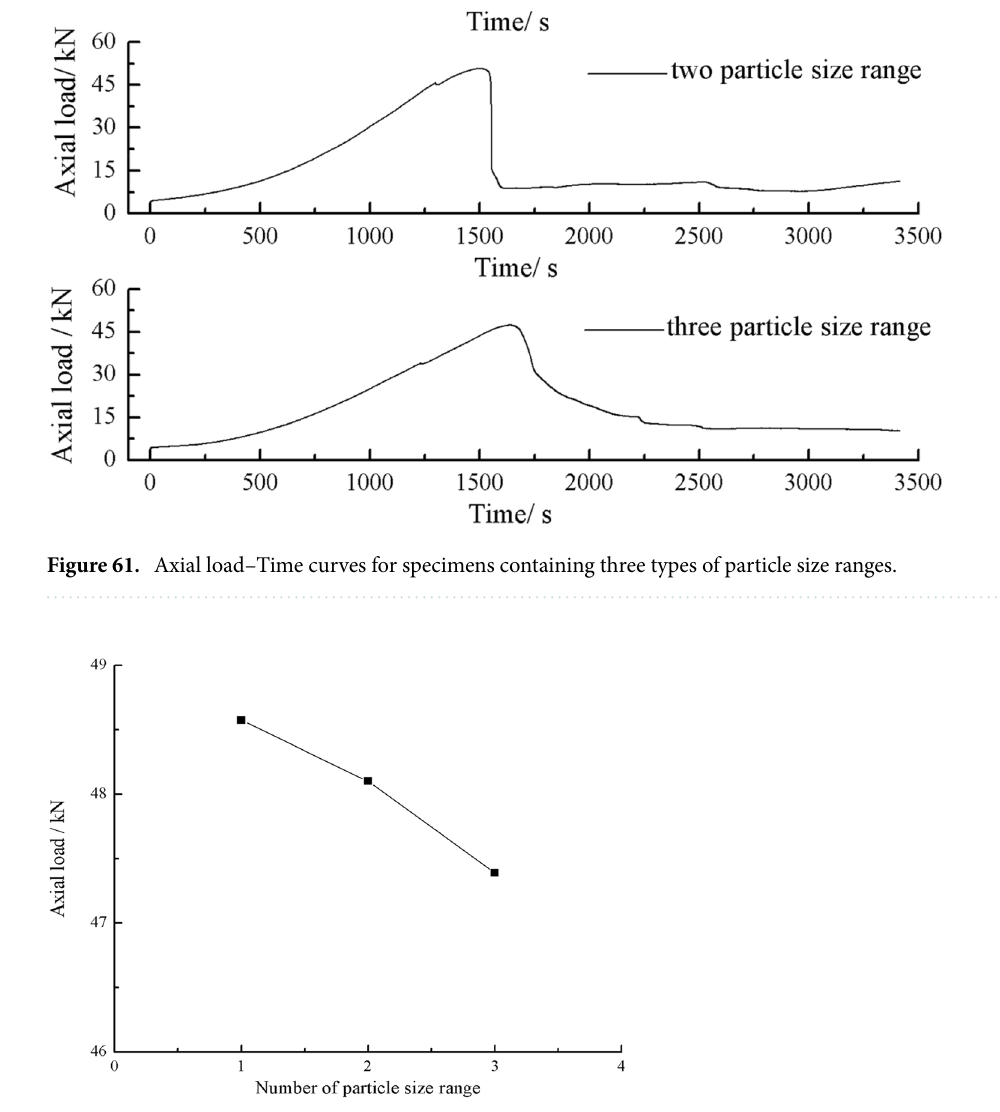
Figure 62. Graph of peak Axial load vs. Number of particle size